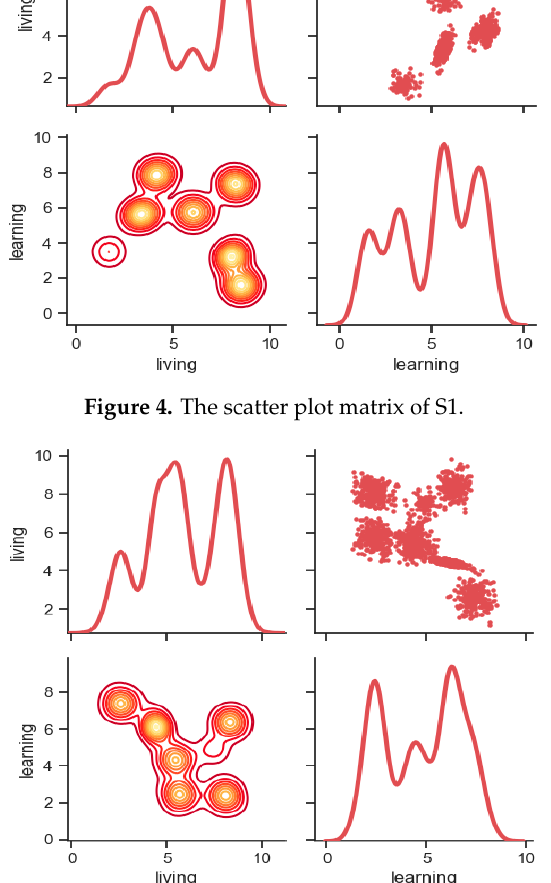
Figure 5. The scatter plot matrix of S2.